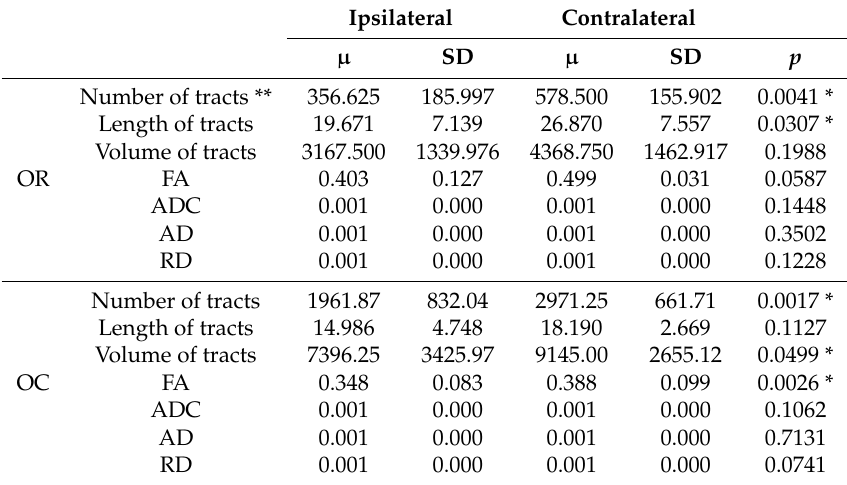
Table 5. DTI values in optic radiation and occipital cortex.